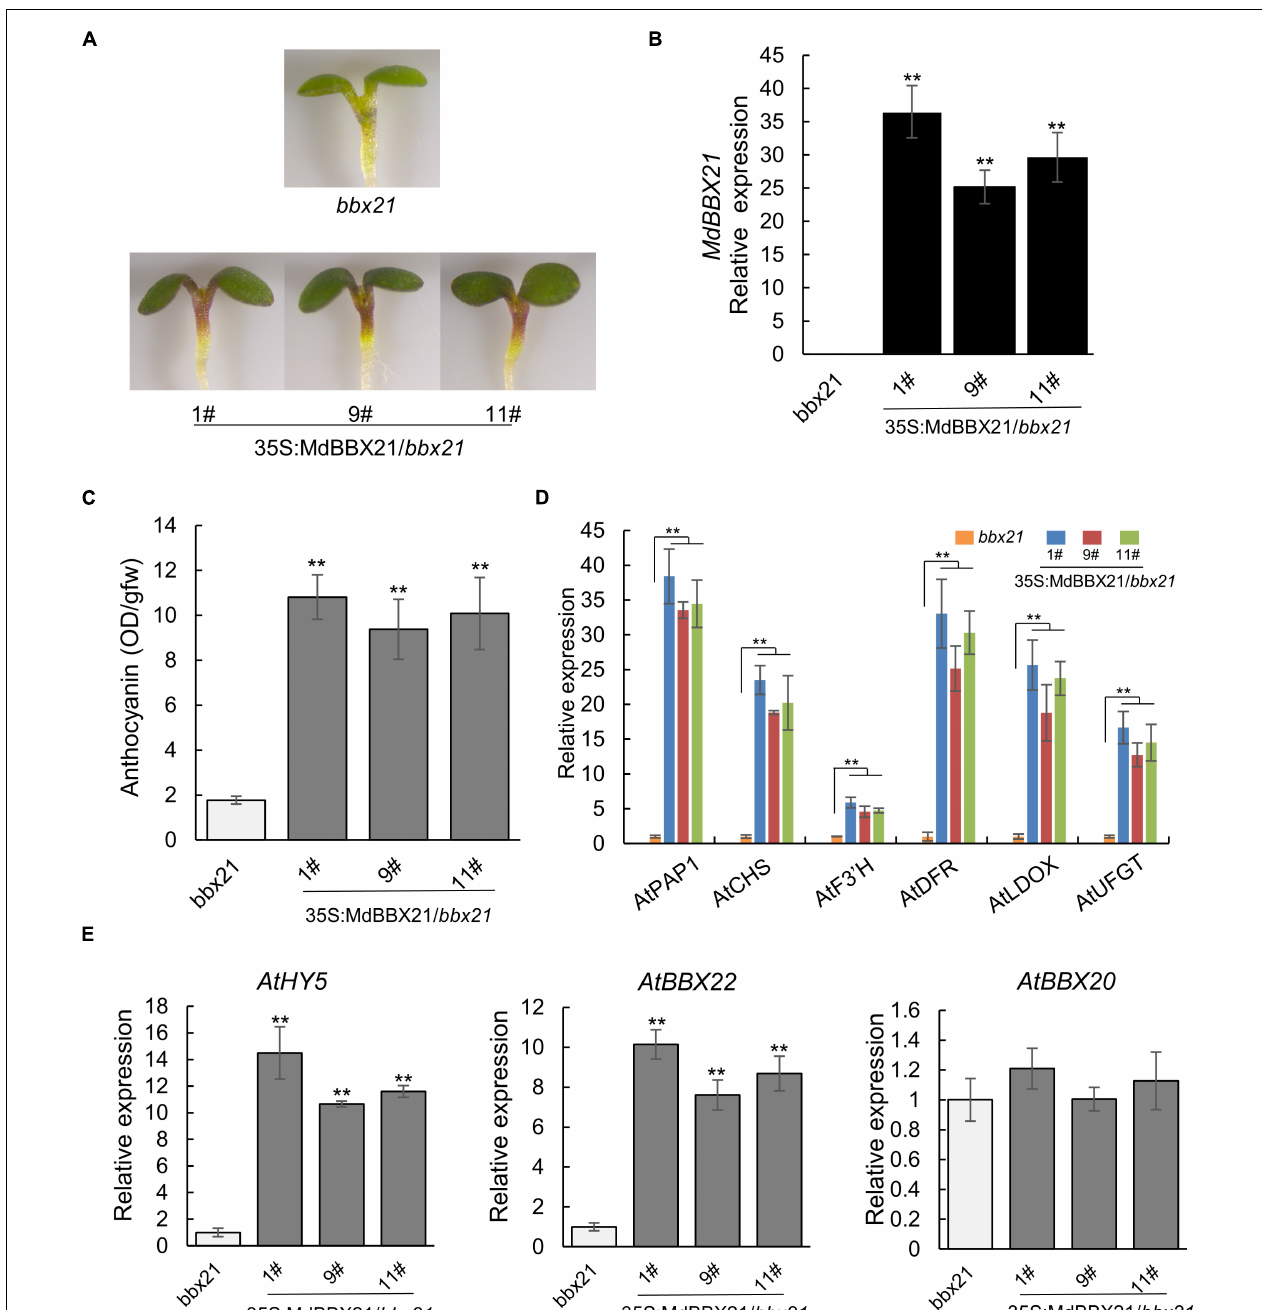
FIGURE 5 | Overexpression of MdBBX21 promotes anthocyanin accumulation in Arabidopsis seedlings. (A) Phenotypes of 35S:MdBBX21/ bbx21 and bbx21 mutant seedlings. 35S:MdBBX21/ bbx21 (#1), 35S:MdBBX21/ bbx21 (#9), and 35S:MdBBX21/ bbx 21 (#11) represent three transgenic lines. (B) The MdBBX21 ’s expression level in 35S:MdBBX21/ bbx21 and bbx21 mutant seedlings. (C) Anthocyanin content in 35S:MdBBX21/ bbx21 and bbx21 mutant seedlings. (D) Relative expression levels of anthocyanin biosynthesis-related genes in 35S:MdBBX21/ bbx21 and bbx21 mutant seedlings. (E) Relative expression levels of AtHY5 , AtBBX22 , and AtBBX20 in 35S:MdBBX21/ bbx21 and bbx21 mutant seedlings. Error bars represent the standard deviation of three biological replicates. ** P < 0.01 (Student’s t